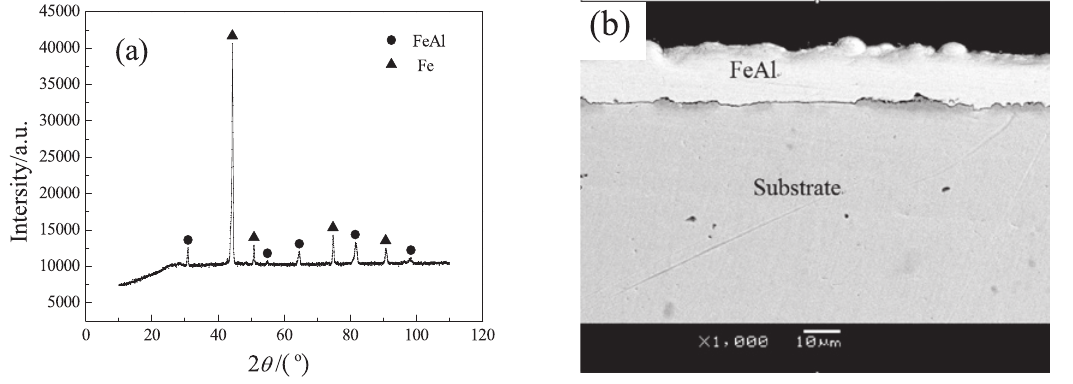
Fig. 1: XRD pattern (a) and cross-sectional morphology (b) of the VA sample